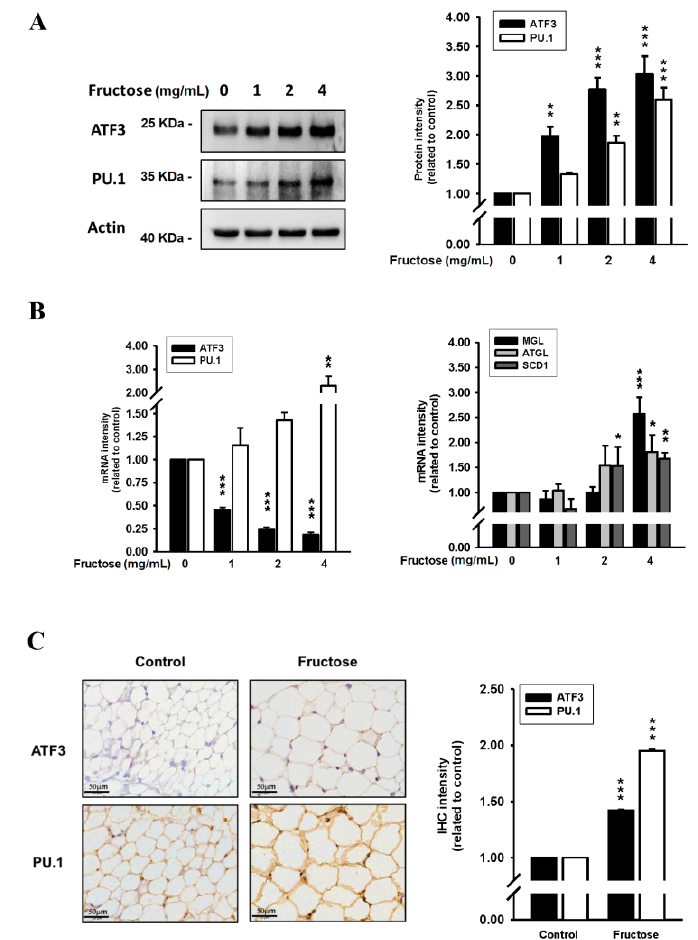
Figure 2. Effects of different fructose concentrations on ( A ) ATF3 and PU.1 protein levels in adipocytes in vitro, ( B ) ATF3, PU.1, MGL, ATGL, and SCD1 mRNA levels in adipocytes in vitro, and ( C ) the immunohistochemistry intensity of ATF3 and PU.1 obtained from our previous study [17]. N = 6, the results from 6 independent experiments in cell culture experiments and from 6 mice in tissue used study. Values are presented as mean ± SD. *, **, and *** denote p < 0.05, <0.01, and <0.001 vs. the control groups at Day 7 of the experimental protocol, respectively.